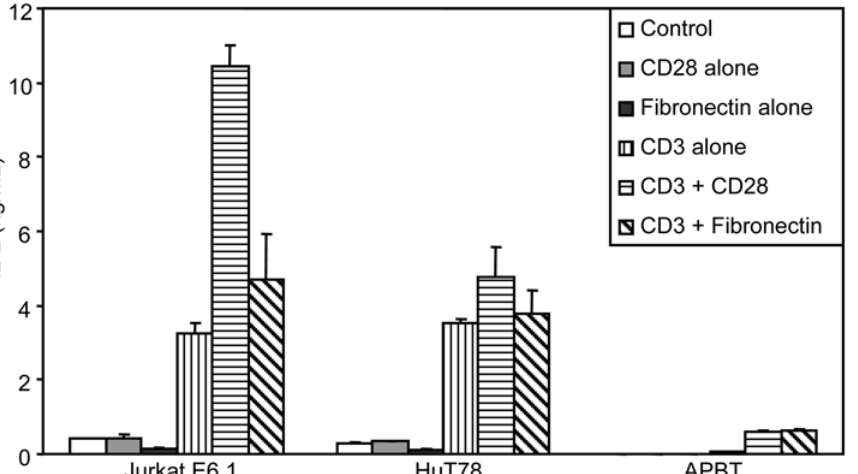
Figure 11. Jurkat E6.1 T cells and HuT78 T cells have aberrant IL-2 production compared to APBTs. Jurkat E6.1 T cells, HuT78 T cells and APBTs were stimulated using a CD3 antibody (1 m g/mL), both alone and in combination with a stimulatory CD28 antibody (2 m g/mL) and fibronectin (1 m g/mL). The production of IL-2 after 24 hours of stimulation was assessed by ELISA as described above. doi:10.1371/journal.pone.0005430.g011 (Figure 11). HuT78 T cells also have abnormal c-myc function and over express Bcl-xL, which indicates possible problems with the